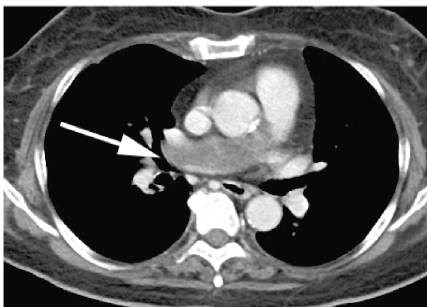
Figure 1: A contrast-enhanced computed tomography scan showing a tumor (arrow) in the right main pulmonary artery.